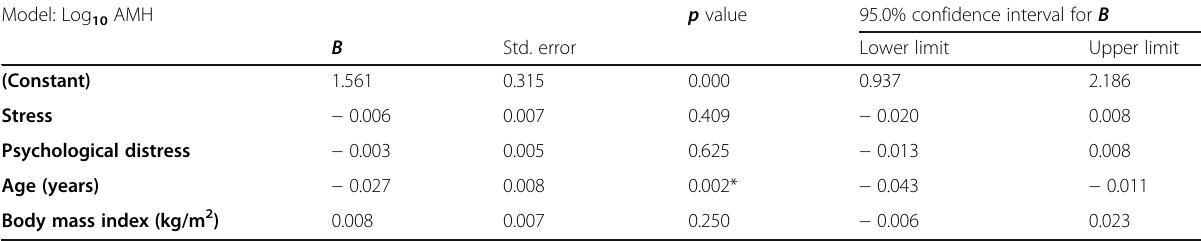
Table 4 Multivariate linear regression among fertile women Model: Log 10